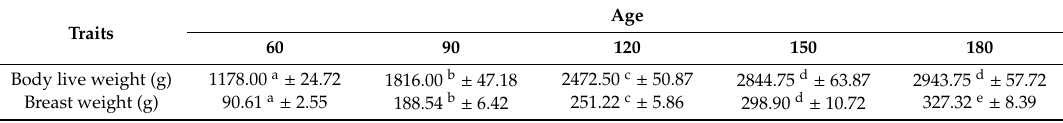
Table 2. E ff ect of age on growth performance of Da-Heng meat type